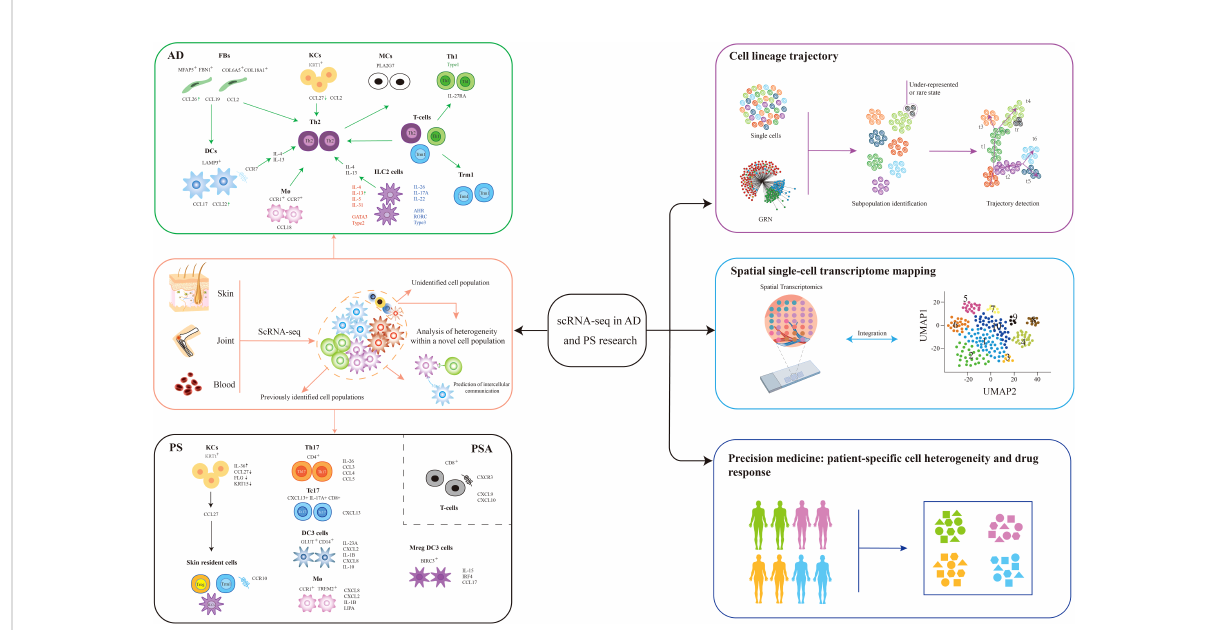
FIGURE 1 Application of scRNA-seq in AD and PS. Single-cell RNA sequencing (scRNA-seq) is especially useful in the detection of rare cell populations, identifying cell-to-cell interactions, reconstructing skin cell trajectories, spatial transcriptomic mapping of skin (75), and developing more precision medicine tools for the better prediction of patient-speci fi c drug responses. The future trends involved cell-to-cell communication, skin cell trajectories, spatial transcriptomic mapping of skin, and precision medicines in these diseases. AD, atopic dermatitis; PS, psoriasis; FBs, fi broblasts; KCs, keratinocytes; MCs, melanocytes; Th1, T helper 1; Th17, T helper 17; Tc17, expressing IL-17 cytotoxic CD+8 T cell; Trm, skin- resident memory T cell; Treg, regulatory T cell; DC, dendritic cell; Mreg DC, mature dendritic cell enriched in immunoregulatory molecules; ILC, innate lymphoid cell; Mø, macrophage; CCL, CC chemokine ligand; CXCL, C-X-C motif ligand; GRN, gene regulatory network; t-SNE, t- distributed stochastic neighbor